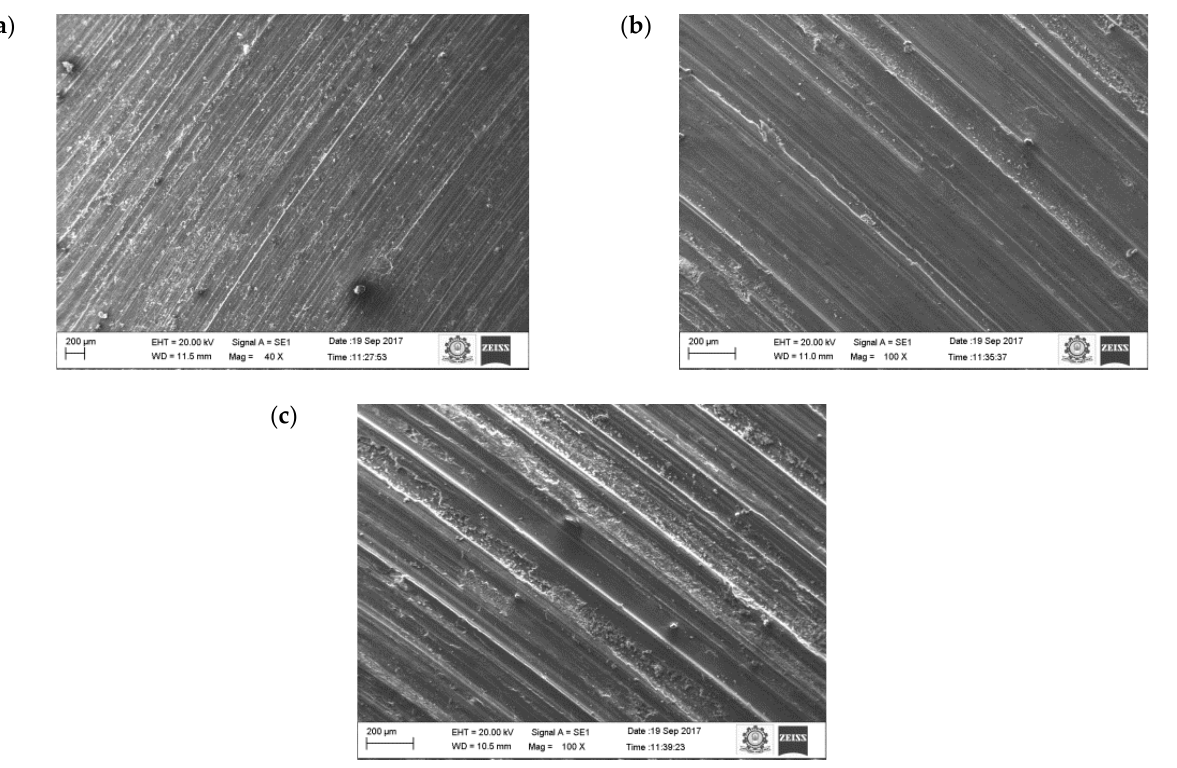
Figure 15. Worn surface of the hybrid composite: ( a ) 0.75 m/s ( b ) 1.5 m/s ( c ) 2.25 m/s.